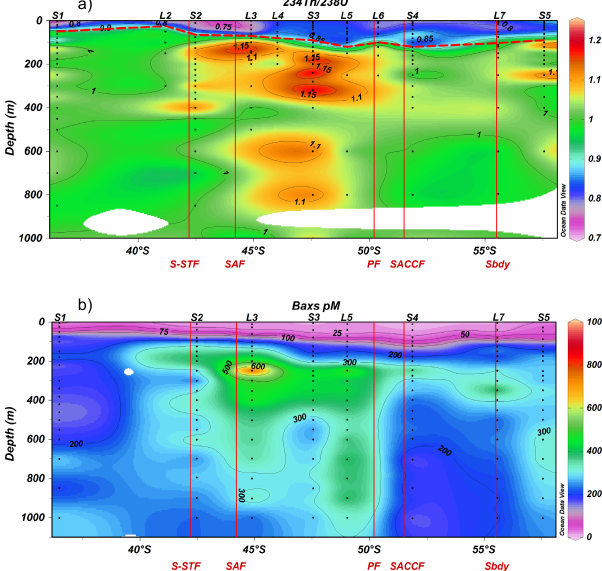
Fig. 3. Latitudinal section of (a) total 234 Th/ 238 U activity ratios and (b) biogenic particulate Ba (Ba xs ) in the upper 1000m. Major frontal systems are indicated by vertical lines. The red dotted line indicates the mixed − layer depth (MLD). Schlitzer, 2003; Ocean Data View; http://www.awi-bremerhaven.de/GEO/ODV.